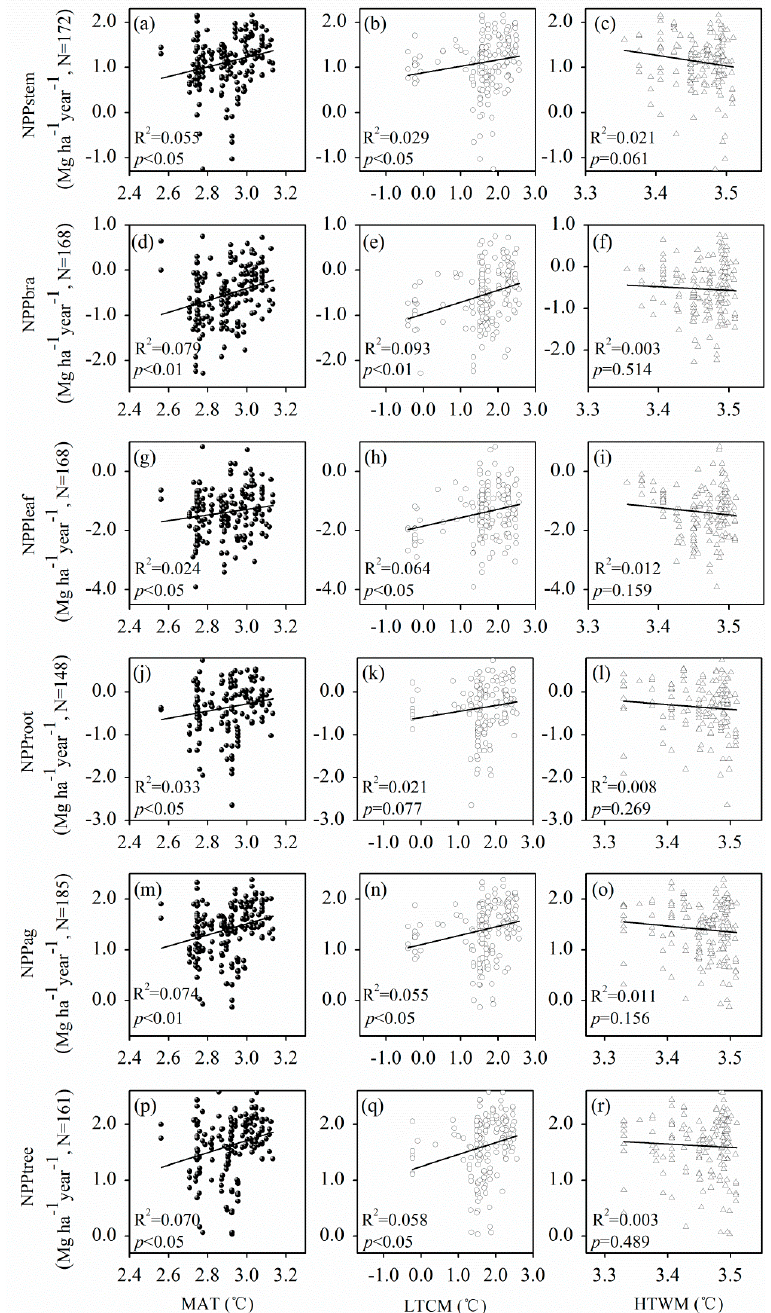
Figure 5. The relationships between P. massoniana net primary productivity (NPP) and MAT ( a , d , g , j , m , p ), LTCM ( b , e , h , k , n , q ), and HTWM ( c , f , i , l , o , r ) on a logarithmic (ln) scale. Mean annual temperature (MAT); mean low temperatures in cold months (LTCM); mean high temperatures in warm months (HTWM).